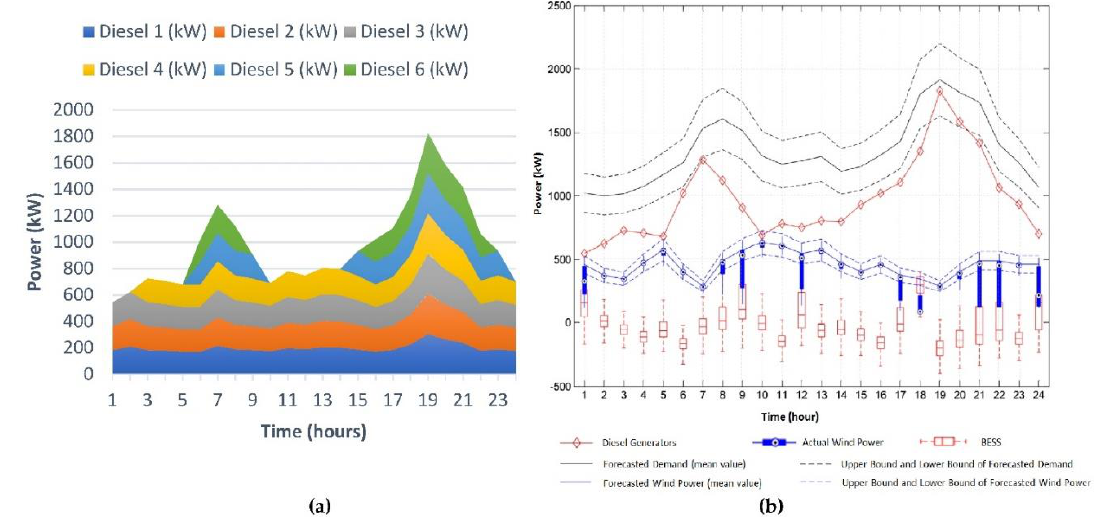
Figure 9. Case 1b results (frequency criteria considered): ( a ) optimal daily schedule for the DGs and ( b ) box plots of wind power, ESS power, DG power, and forecasted demand.